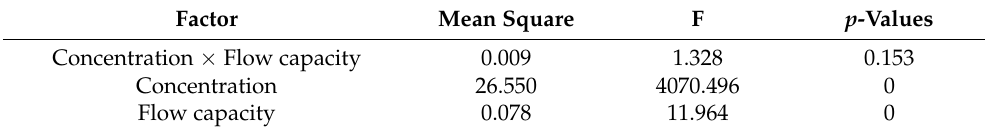
Table 3. Inter-subject effect test.